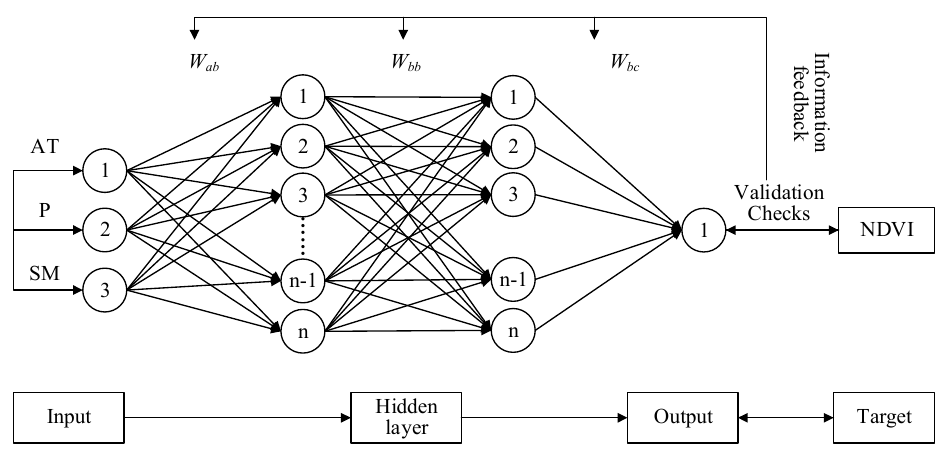
Figure 2. The structure of the artificial neural network model.